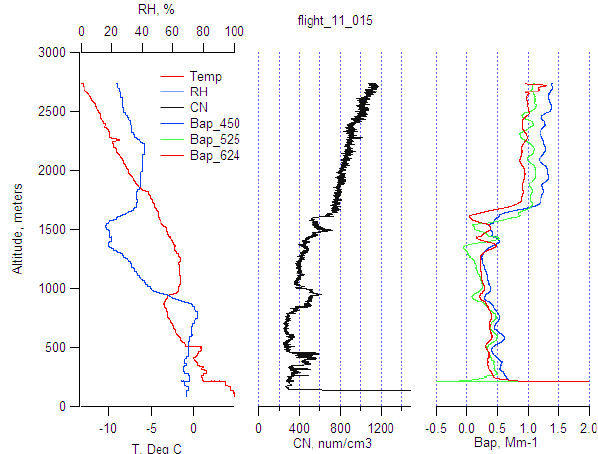
Fig. 4. The NOAA Manta flight tracks during the 2011 NOAA- STADS/CICCI campaigns. A Landsat ETM + mosaic from 1999 is used in the background. The flight with in which the aerosol layer was identified on 26 April is highlighted with yellow dash.